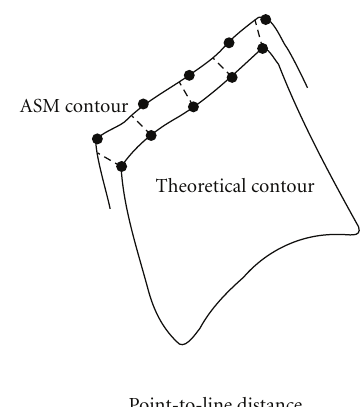
Figure 5: Point-to-line distance characterizing the error between a theoretical contour and an ASM-segmented